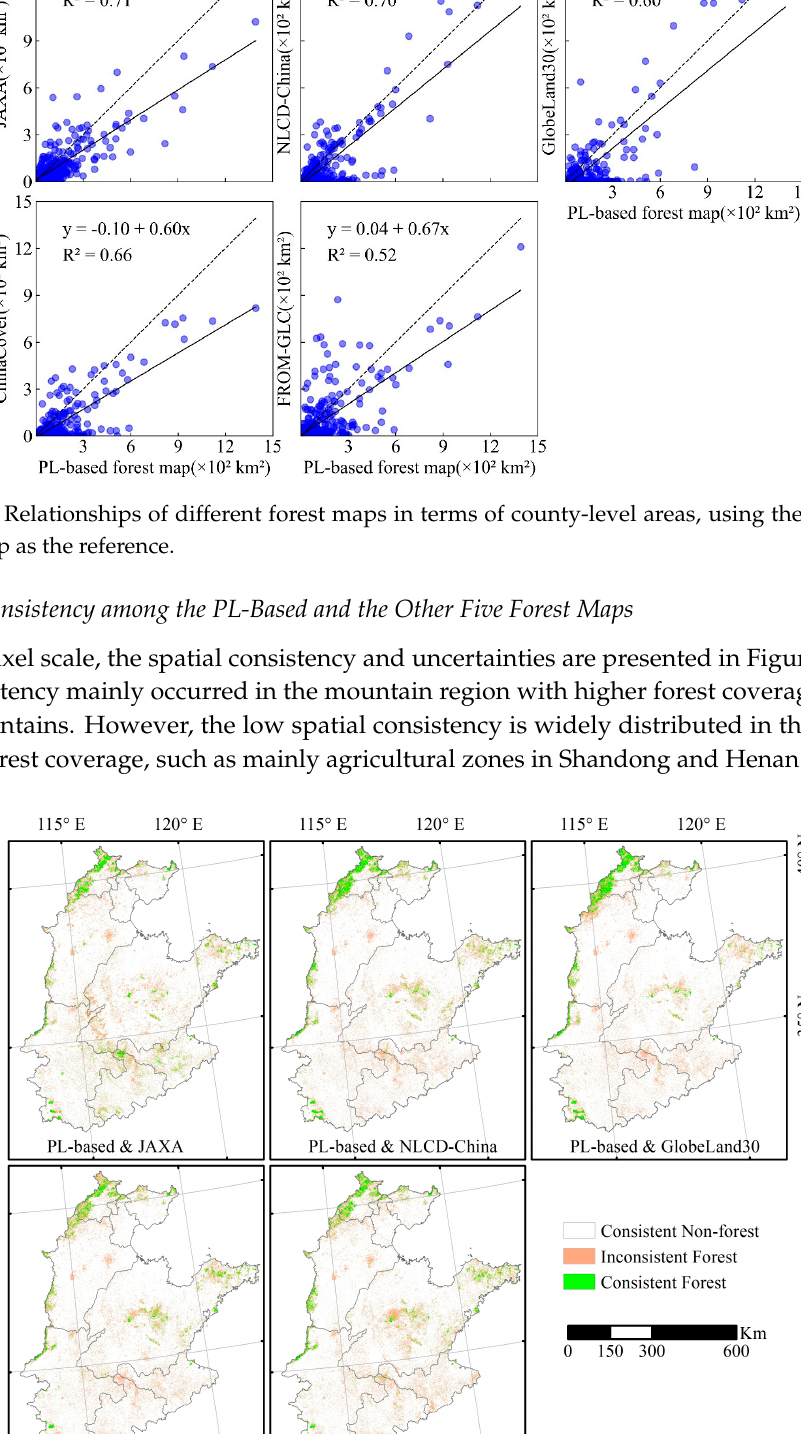
Figure 9. Spatial comparison between the PL-based and other forest maps.